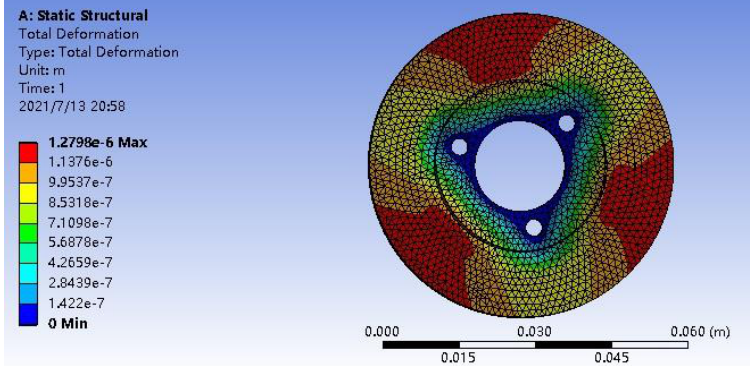
Figure 7. Equivalent total strain diagram of stator.